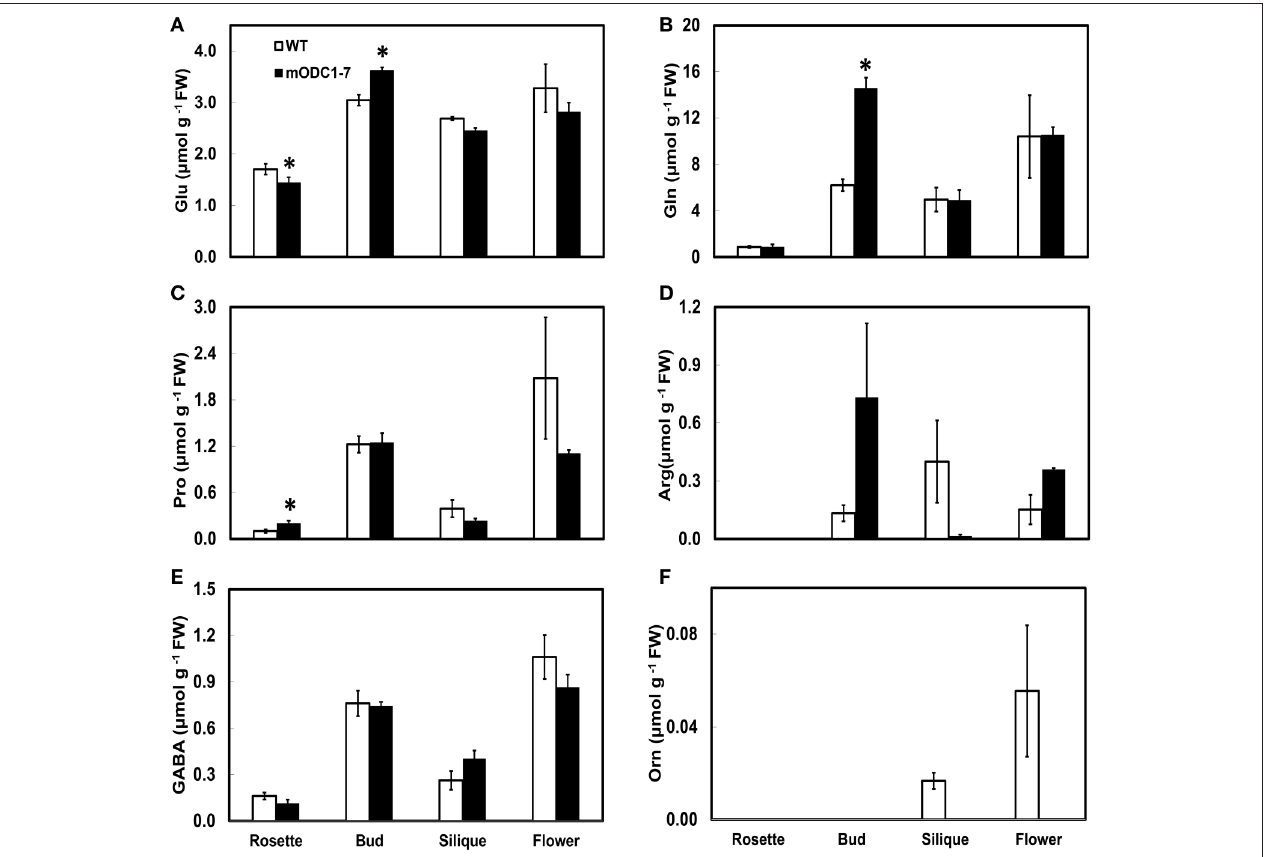
FIGURE 6 | Cellular concentrations of amino acids (A) Glu, (B) Gln, (C) Pro, (D) Arg, (E) GABA, and (F) Orn, in different tissues of mature (6 week-old) WT and 2x 35S ::m ODC -1-7 transgenic Arabidopsis thaliana plants. Data are mean of 3 ± SE; each replicate consists of 2–3 individual plants. * Denotes significant difference between WT and m ODC transgenic plants for each particular organ ( P ≤ 0.05 ).